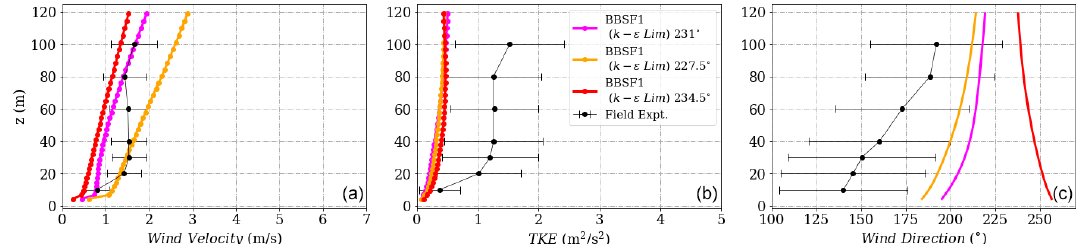
Figure D11. (a) Wind velocity magnitude, (b) wind direction and (c) turbulent kinetic energy at Tower 25 (tse09) for the BBSF model.